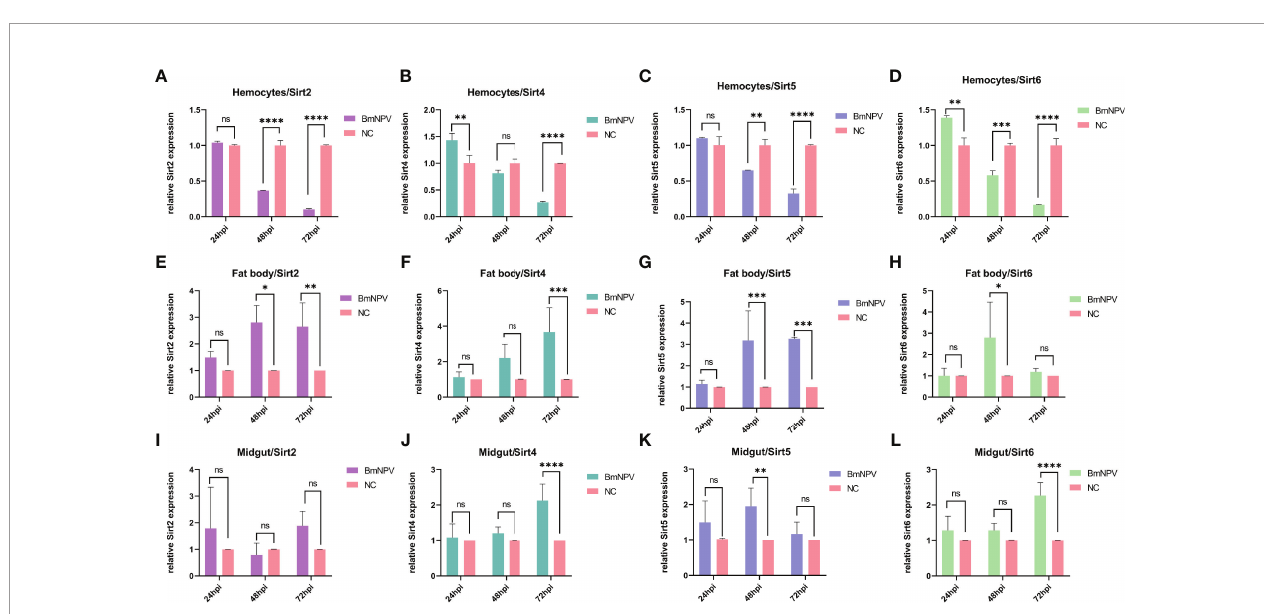
FIGURE 2 | Expression of Sirtuin family genes in hemocytes, fat body and midgut after BmNPV infection in the silkworm. (A – D) Detection of the expression of BmSirt2 , BmSirt4 , BmSirt5 and BmSirt6 in hemocytes. (E – H) Transcriptional response of BmSirt2 , BmSirt4 , BmSirt5 and BmSirt6 to BmNPV infection in fat body. (I – L) Detection of the expression of BmSirt2 , BmSirt4 , BmSirt5 and BmSirt6 in midgut. Negative control represents uninfected larvae. Each bar represents the mean ± SD. *p < 0.05, **p < 0.01, ***p < 0.001, ****p < 0.0001. ns, not signi fi cant.